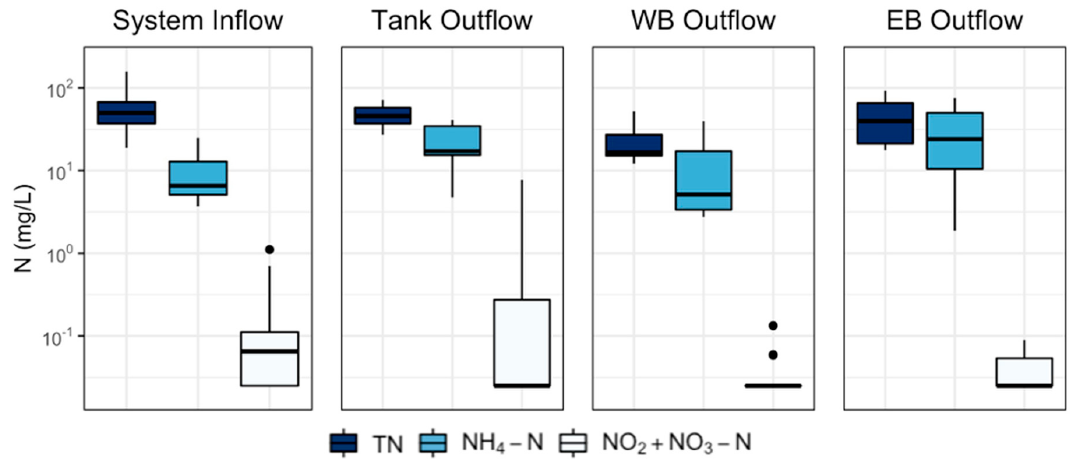
Figure 4. Box and whisker plots of nitrogen (N) species concentrations from each sampling location. Bottom and top boxes indicate 25th and 75th percentiles, respectively, the middle line shows the median, whiskers show the min and max, and points denote any outliers. TN = total N, NH 4+ -N = ammonium-N, NO 2 - +NO 3 – N = nitrite + nitrate-N.